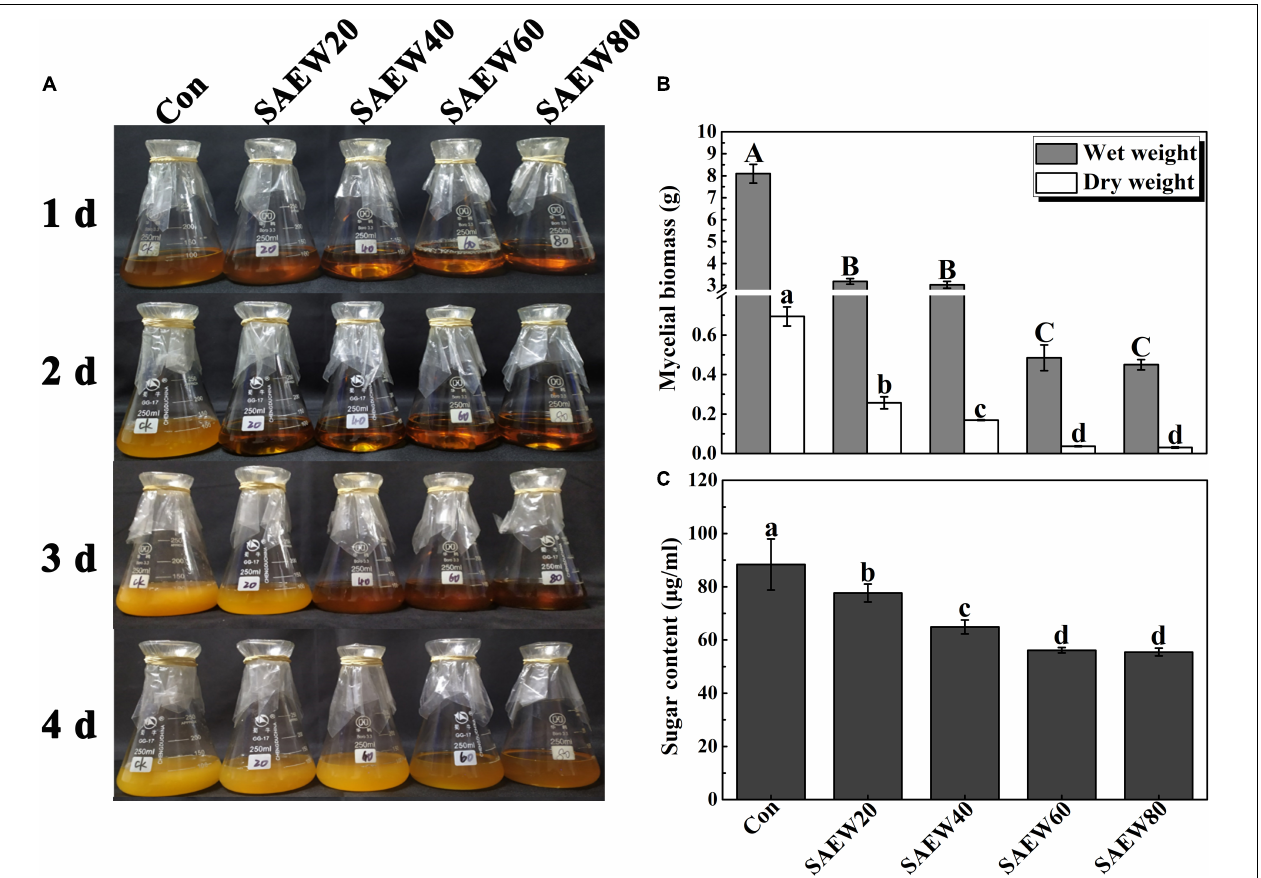
FIGURE 4 | Effects of SAEW on the growth of Fusarium oxysporum f. sp. niveum (FON) mycelium. (A) shows the phenotype of the FON mycelium with different treatments. (B,C) show the mycelium biomass and sugar content of FON mycelium, respectively. Different concentrations of SAEW were added to the same initial concentration of FON suspension liquid. Vertical bars represent the standard deviation (SD) of the mean of nine biological replicates ( n = 9). The data were collected from three independent experiments with three biological replicates for each. Different letters indicate significant differences at P < 0.05 according to the Duncan’s multiple range test. Con and control (deionized water); SAEW20 (20 ppm concentration of slightly acidic electrolyzed water); SAEW40 (40 ppm concentration of slightly acidic electrolyzed water); SAEW60 (60 ppm concentration of slightly acidic electrolyzed water); SAEW80 (80 ppm concentration of slightly acidic electrolyzed water); FON, Fusarium oxysporum f. sp. Niveum